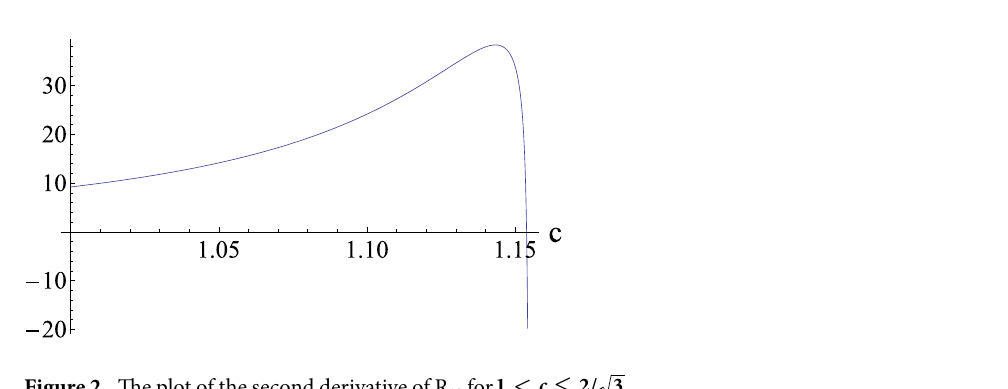
Figure 1. The plot of lower bound (dashed line) and upper bound (dotted line) for α = 3, m = 3. The upper bound consists of two segments and the lower bound consists of three segments. The solid line corresponds to R 11 , R 12 and R 21 .